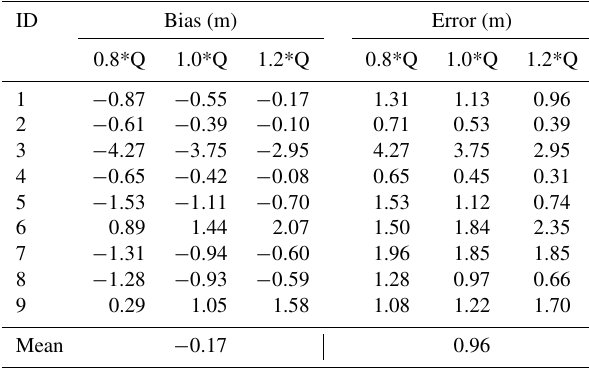
Table 1. Results of the benchmarking of nine events against sur- veyed high water